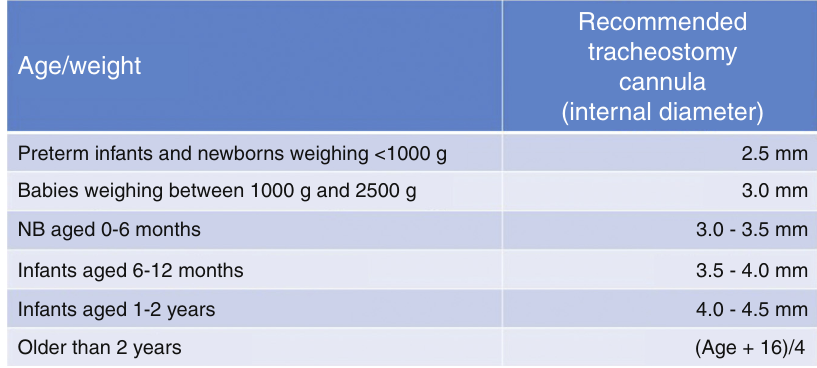
Figure 2 Diameter of tracheostomy cannula appropriate for age/weight. The number of the tracheostomy cannula corresponds to the internal diameter in millimeters (mm). NB, newborn; g, grams.